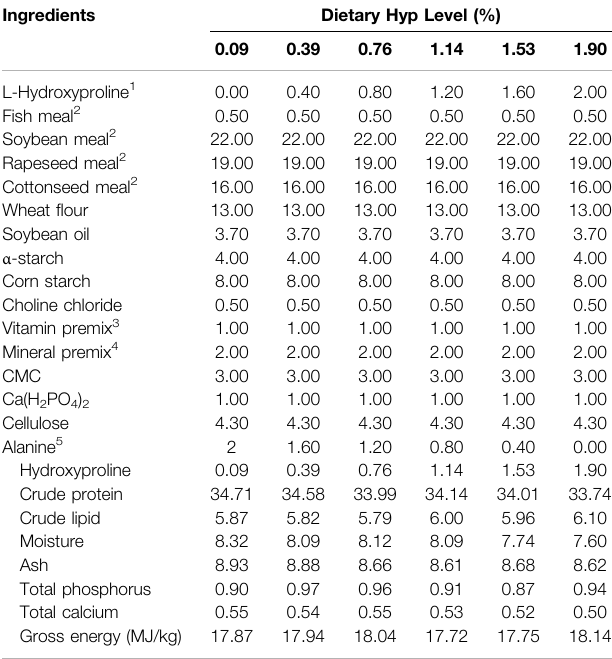
TABLE 1 | Formulation and chemical composition of the experimental diets for ITCC (% dry matter).